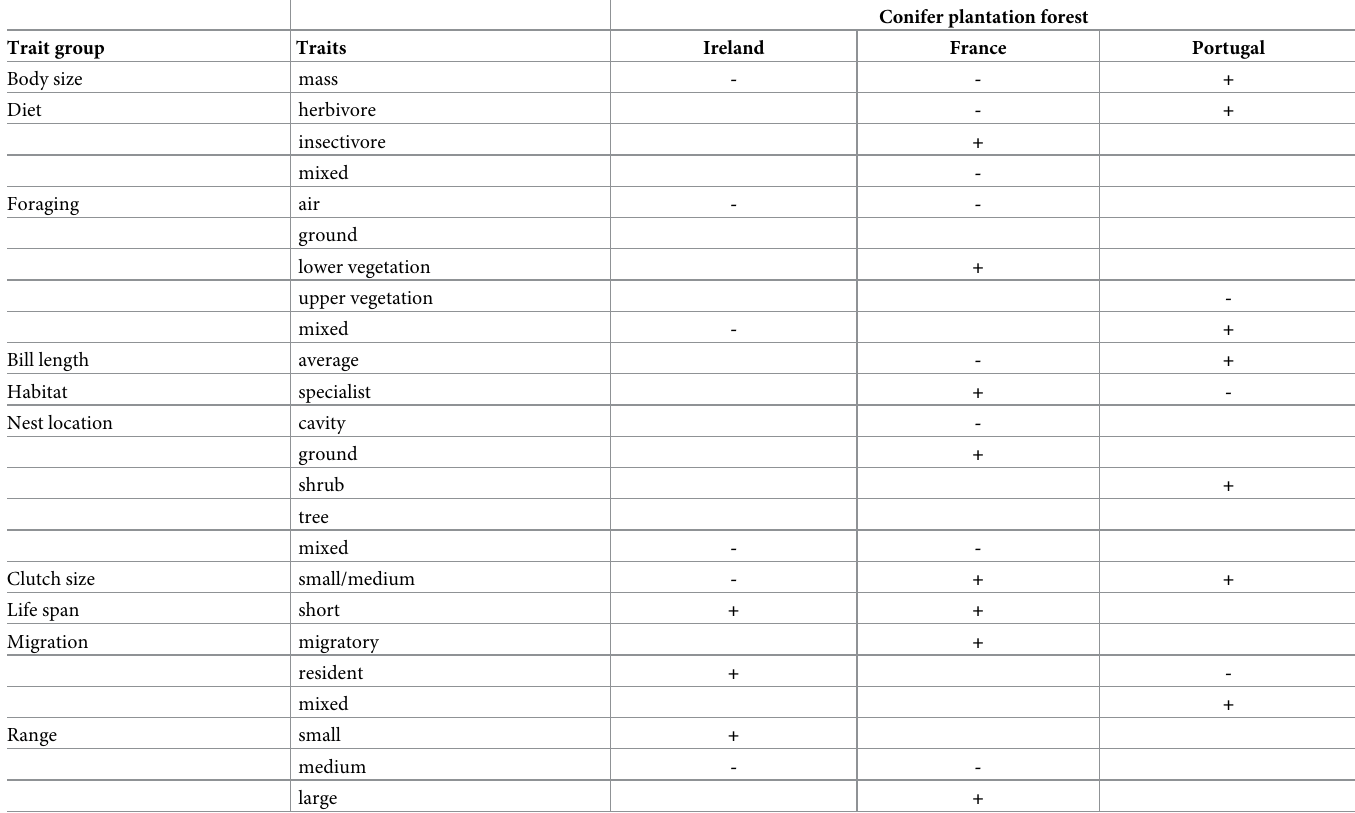
Table 1. Species trait relationships within conifer plantation forests relative to semi-natural oak forests in Ireland, France and Portugal, as calculated with fourth- corner correlations between traits and environmental variables (see S3 Table for fourth corner test